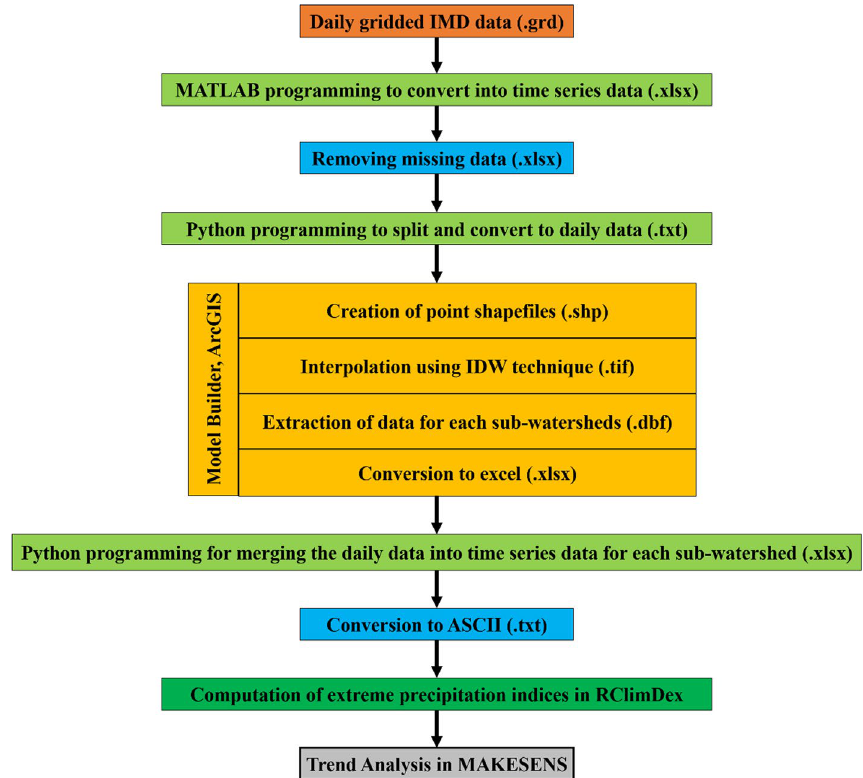
Fig. 3 Flow diagram of the methodology adopted in the